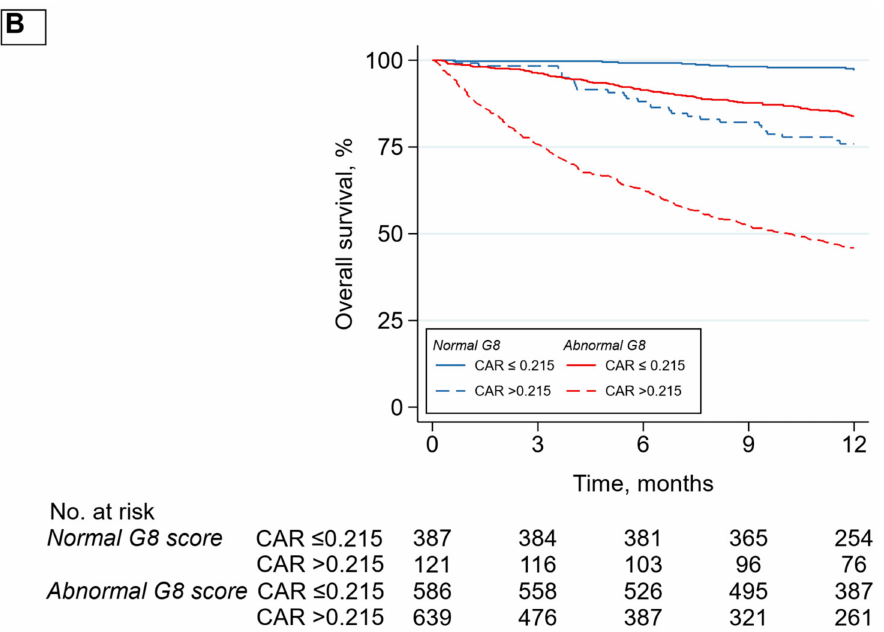
Figure 3. Overall survival according to GPS ( A ) and CRP/albumin ratio ( B ), stratified by G8 score ( n = 1800). GPS: Glasgow Prognostic Score; CAR: C-reactive protein/albumin ratio. Table 3. Discriminant power of models with GPS, mGPS, CRP, albumin and CRP/albumin ratio with regard to one-year mortality in the overall population ( n = 1604 for all models).